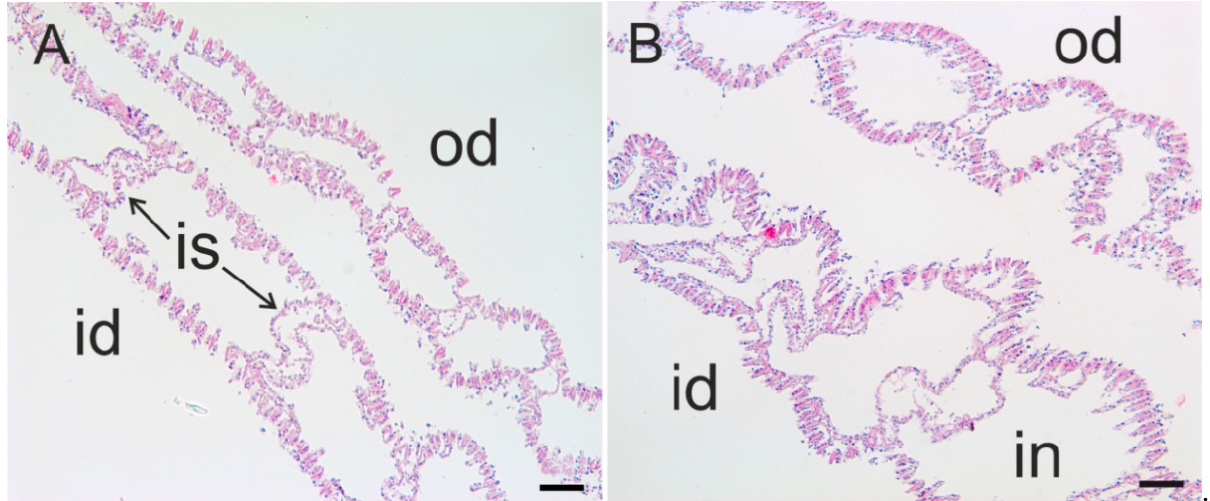
Figure 2. Cross-sections of gills in a brooding specimen: ( A ) left gills; ( B ) right gills. Abbreviations: in, interlamellar space; id, inner demibranch; is, interlamellar septa; od, outer demibranch. Scale bars ( A , B ) = 0.1 mm.